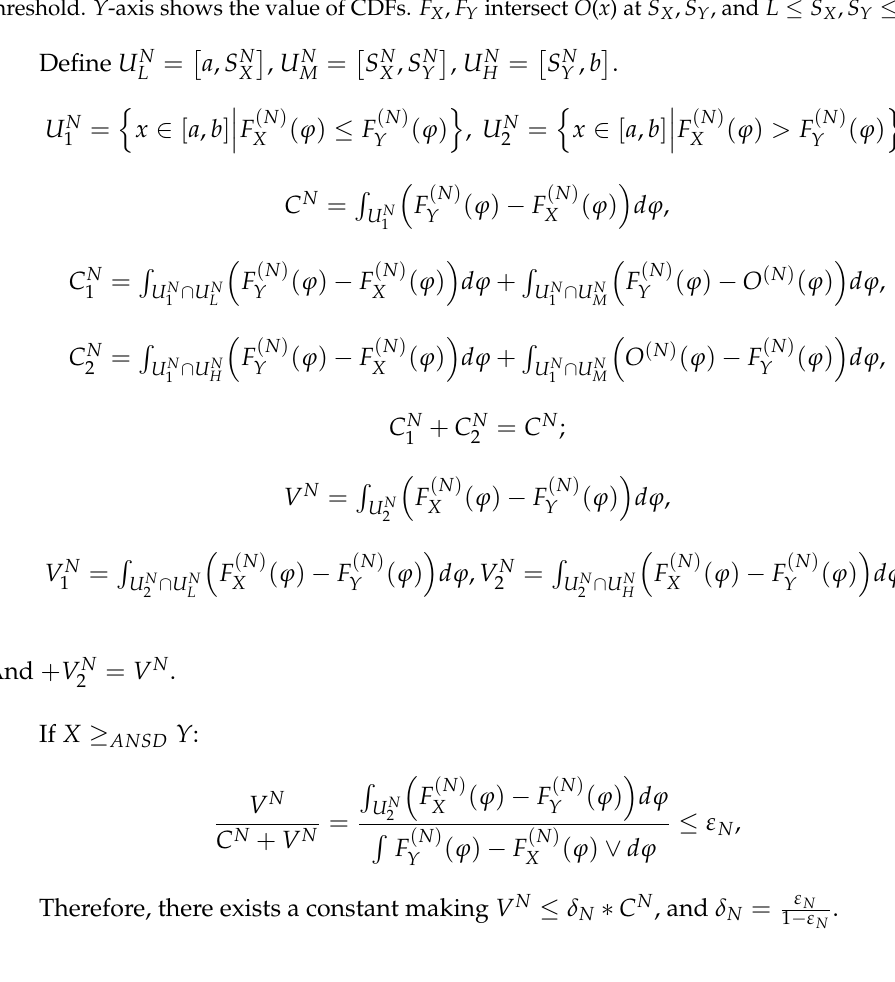
Figure A1. O(x) , 𝐹 (cid:3025) ,𝐹 (cid:3026) are Cumulative Distribution Functions (CDFS). Note: X -axis shows the Figure A1. O ( x ), F X , F Y are Cumulative Distribution Functions (CDFS). Note: X -axis shows the threshold. Y -axis shows the value of CDFs. F X , F Y intersect O ( x ) at S X , S Y , and L ≤ S X , S Y ≤ b